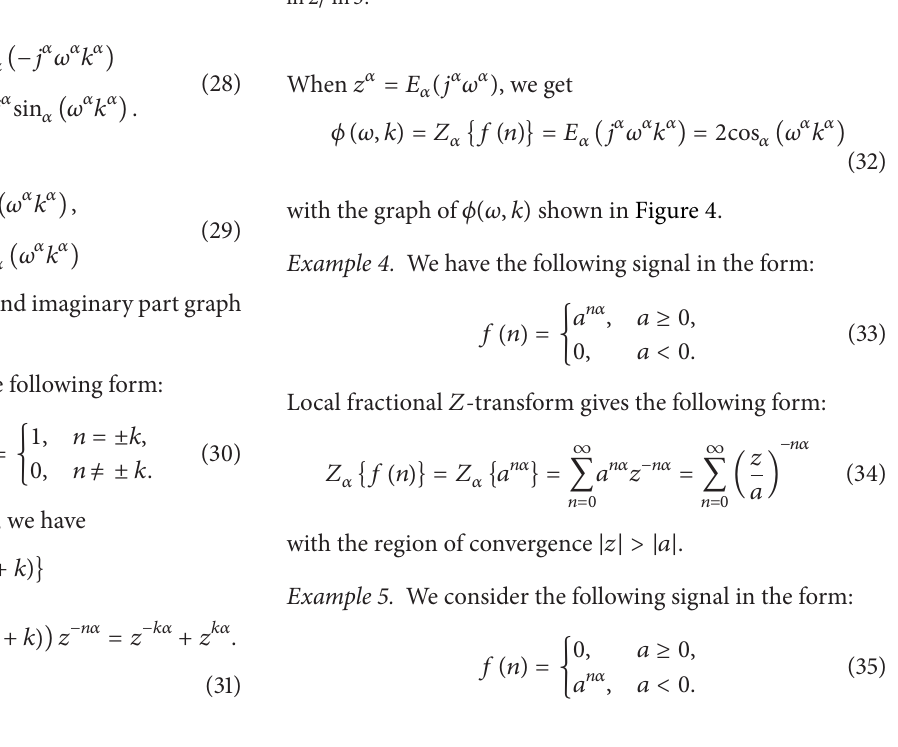
Figure 4: The map of 𝜙(𝜔,𝑘) with premasters 𝜔 = 1 and 𝛼 = ln 2/ ln 3